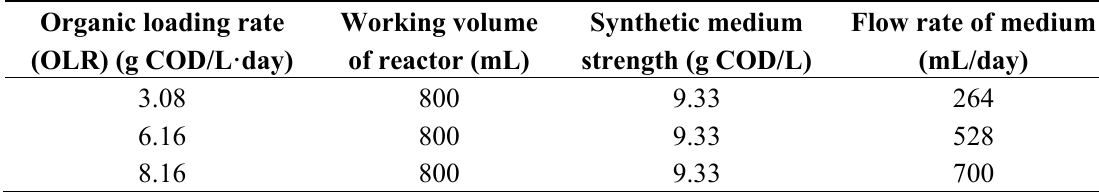
Table 2. Experimental set up of OLR conditions during the semi-continuous digestion process of testing free and encased methane-producing